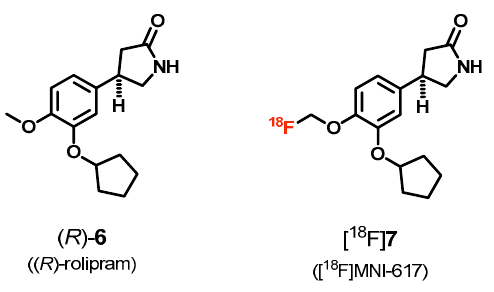
Figure 2. Molecular structures of PDE4 inhibitor ( R )- 6 and the 18 F-analogue thereof for PET.